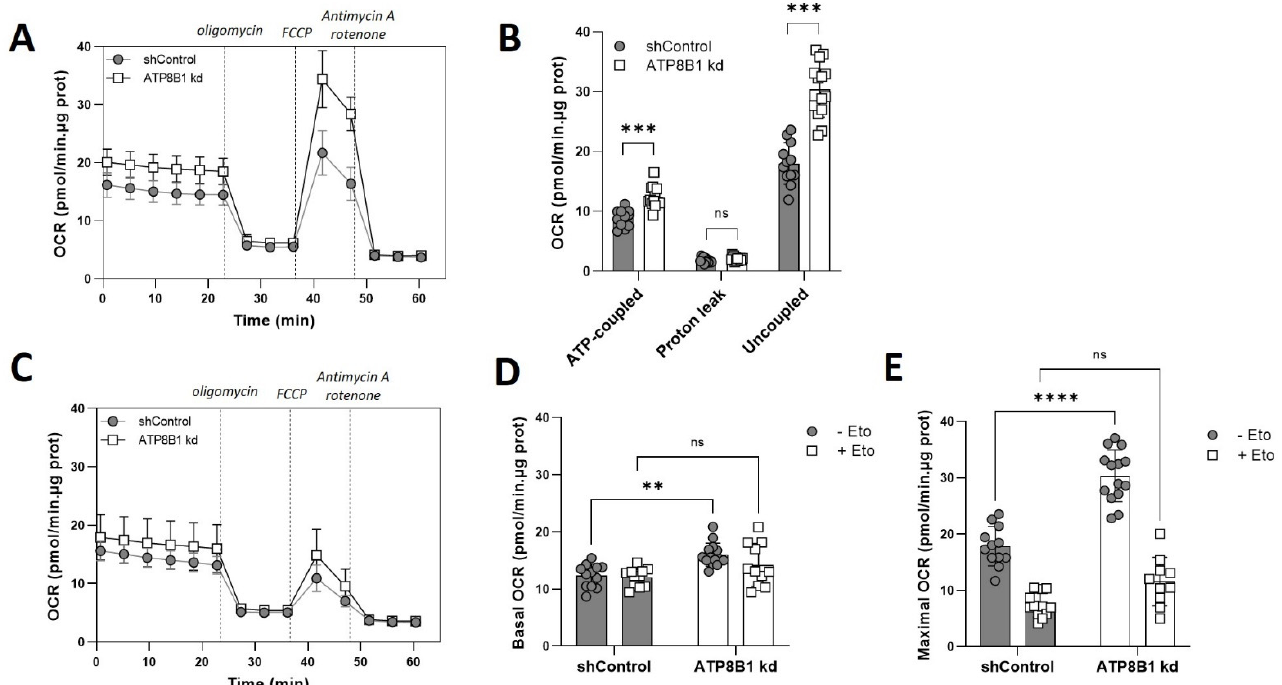
Figure 3. ATP8B1 knockdown coincides with an increased mitochondrial ß-oxidation. ( A ) Oxygen consumption rate (OCR) in the absence of added substrate. Profiles shown are means +/ − s.d. of 12–14 replicates of 2 independent experiments; ( B ) Quantification of ATP-coupled-, leak-associated and uncoupled OCR when no substrate was added. Data are extracted from the data shown in (A), corrected for non-mitochondrial OCR, and are expressed as means +/ − s.d.; *** p < 0.0001 by multiple unpaired t -test; ( C ) Oxygen consumption rate (OCR) in the absence of added substrate with 3 µM etomoxir. Profiles shown are means +/ − s.d. of 12–14 replicates of 2 independent experiments; ( D , E ) Quantification of basal ( D ) and maximal ( E ) respiration (corrected for non-mitochondrial respiration) in the absence of added substrate with/without etomoxir (Eto). Data are expressed as means +/ − s.d. of 11–14 replicates from 2 independent experiments. **** p < 0.0001, ** p < 0.005 by 2way ANOVA with Tukey’s correction for multiple testing; ns, not significant.